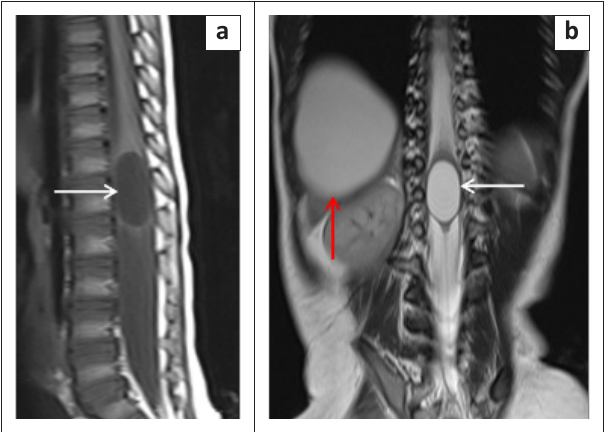
FIGURE 11: Rare case of an intramedullary conus medullaris echinococcus cyst in a 3-year-old girl. Sagittal T1-weighted (a) and coronal T2-weighted (b) images demonstrate an intamedullary cystic lesion (white arrows) that follows CSF signal intensity on all sequences and did not show post-contrast enhancement. Associated finding of a hepatic hydatid cyst (red arrow).